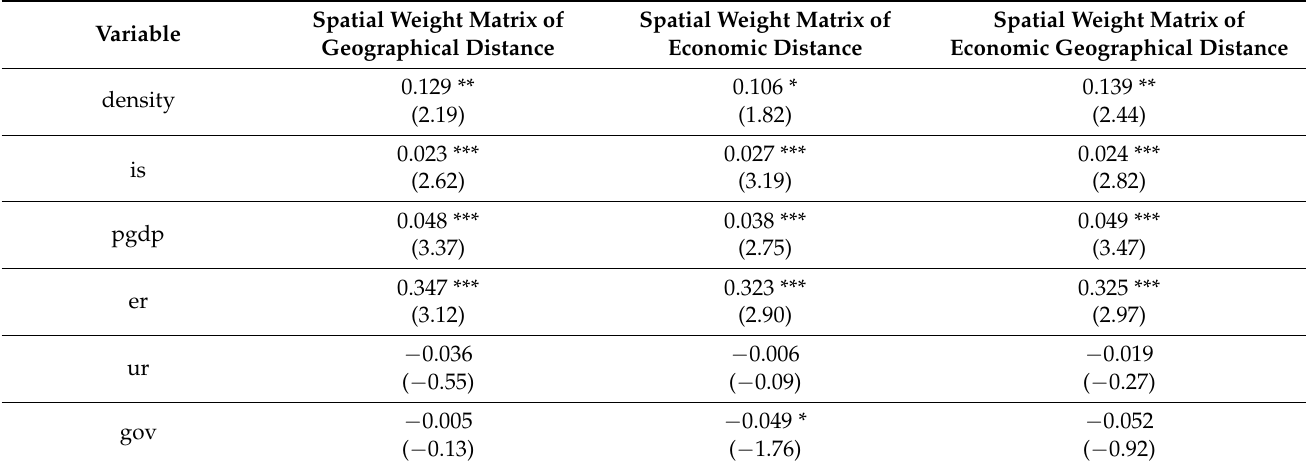
Table 6. The results of the robustness